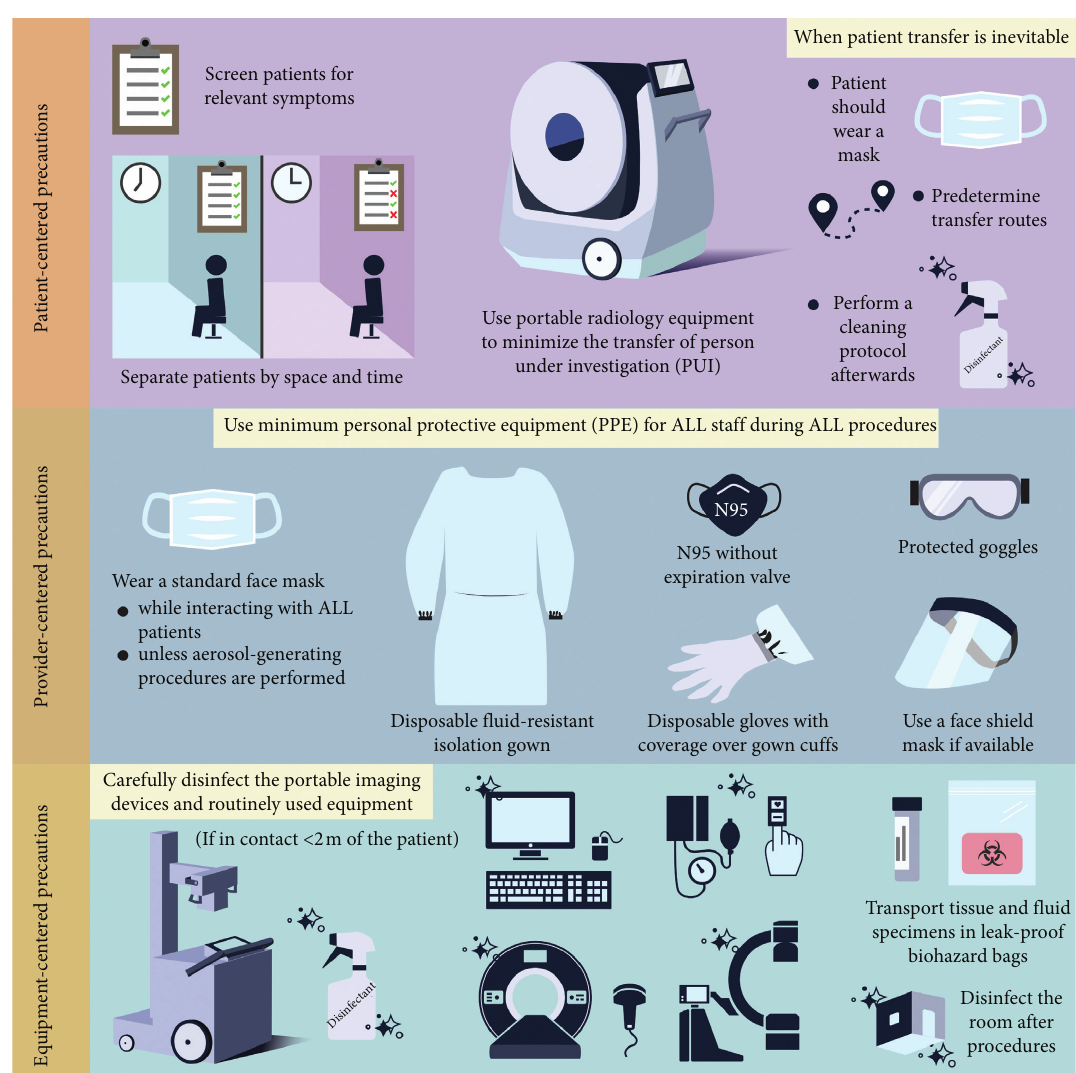
Figure 3: Proposed precautions for diagnostic radiology for COVID-19 outbreak based on the WHO and CDC